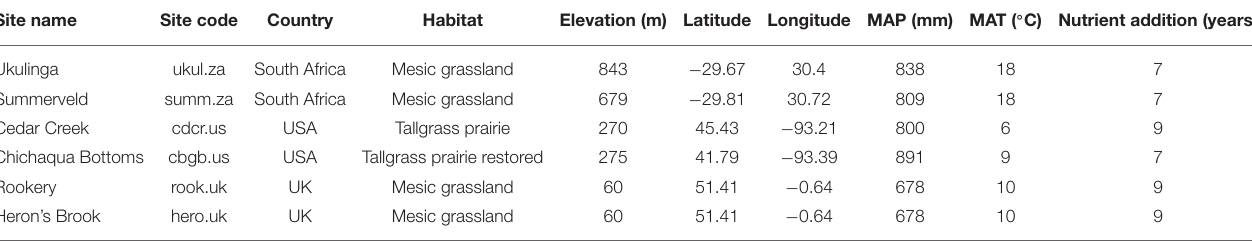
TABLE 1 | Site name, site code, country, habitat, elevation, latitude, longitude, mean annual precipitation (MAP), mean annual temperature (MAT), and the duration of the nutrient addition treatments of the six grassland sites.